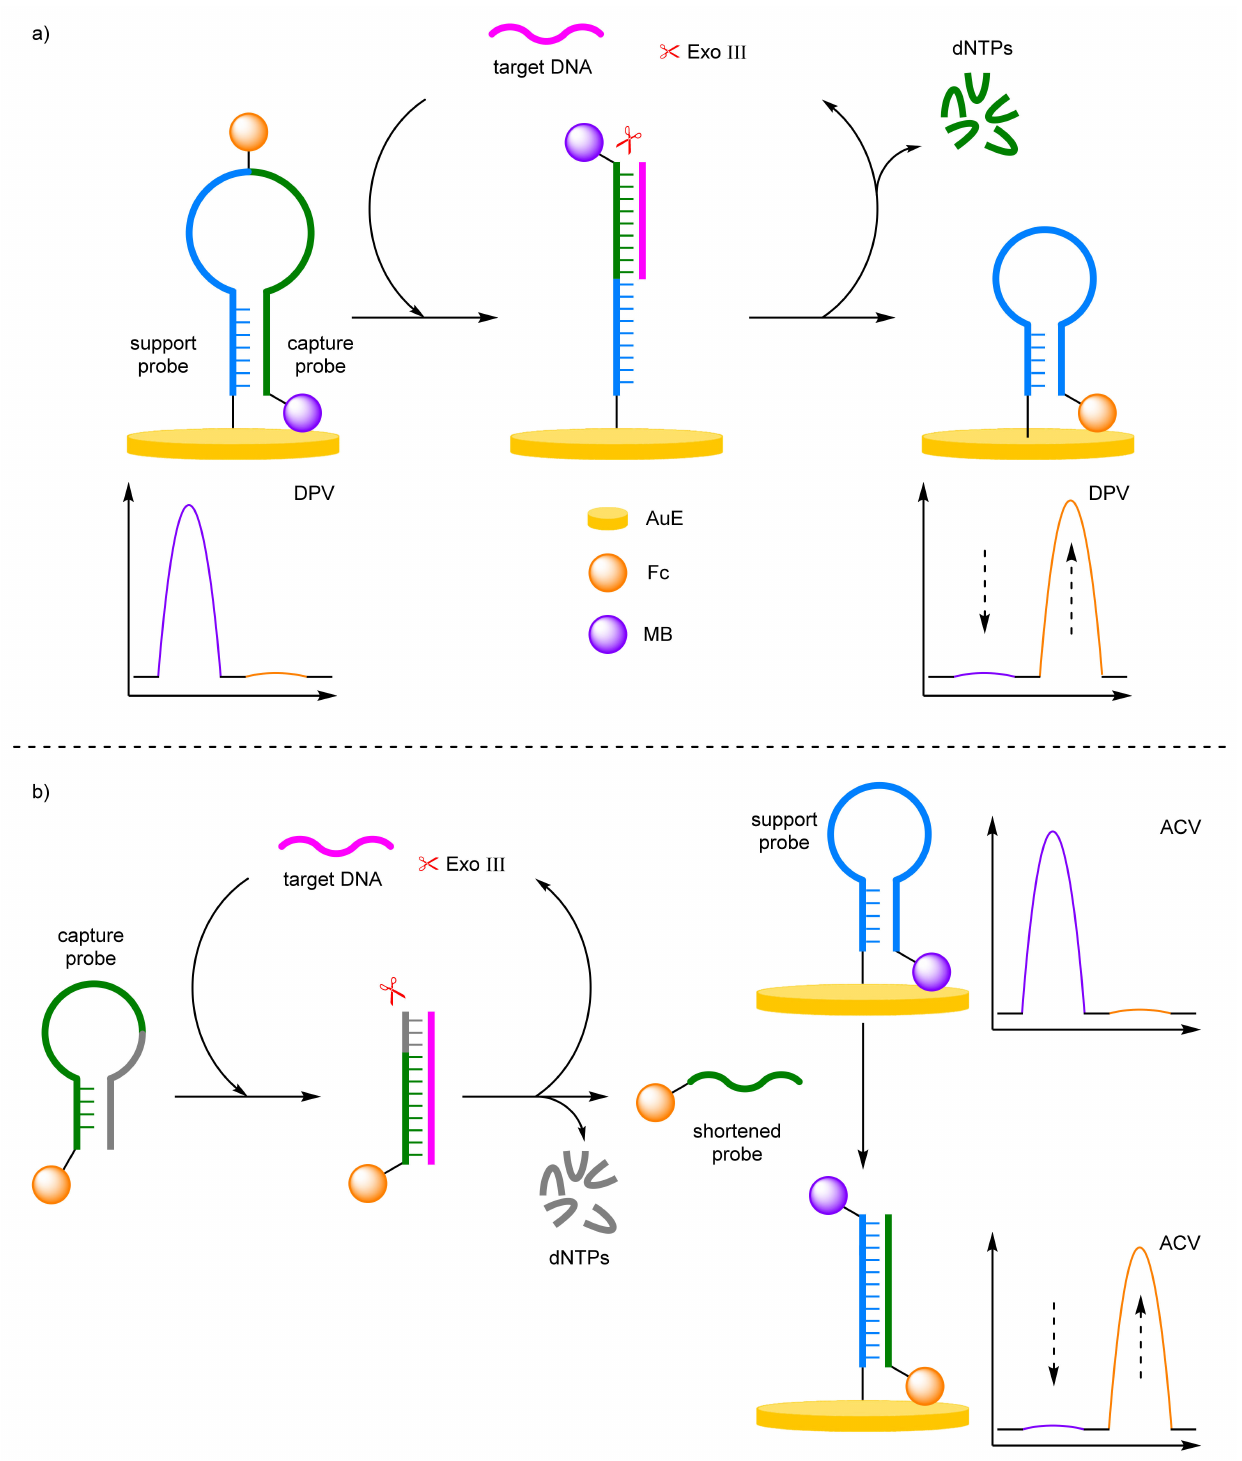
Figure 15. Schematic representation of two exonuclease-based target recycling amplification biosensor: ( a ) a heterogeneous amplification step; ( b ) a homogeneous amplification